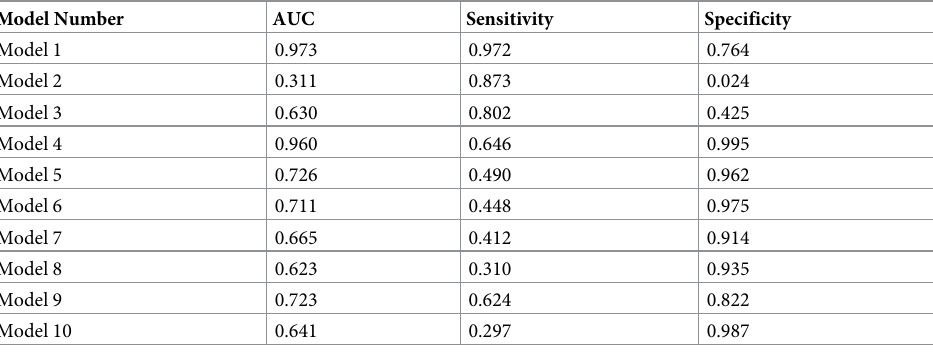
Table 3. Performance of AI models for pneumonia.